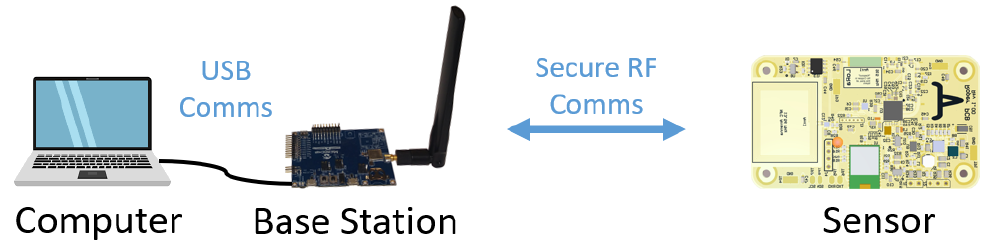
Figure 10. The experimental setup used to validate the firmware update process.